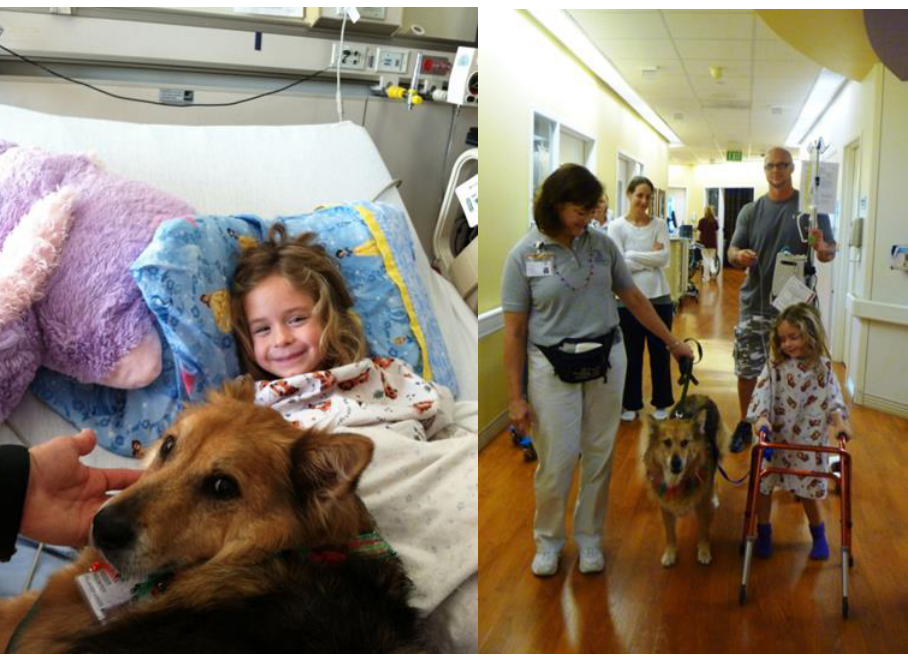
Figure A1. Jordan greets “Jenna” and walks with her as a first step to